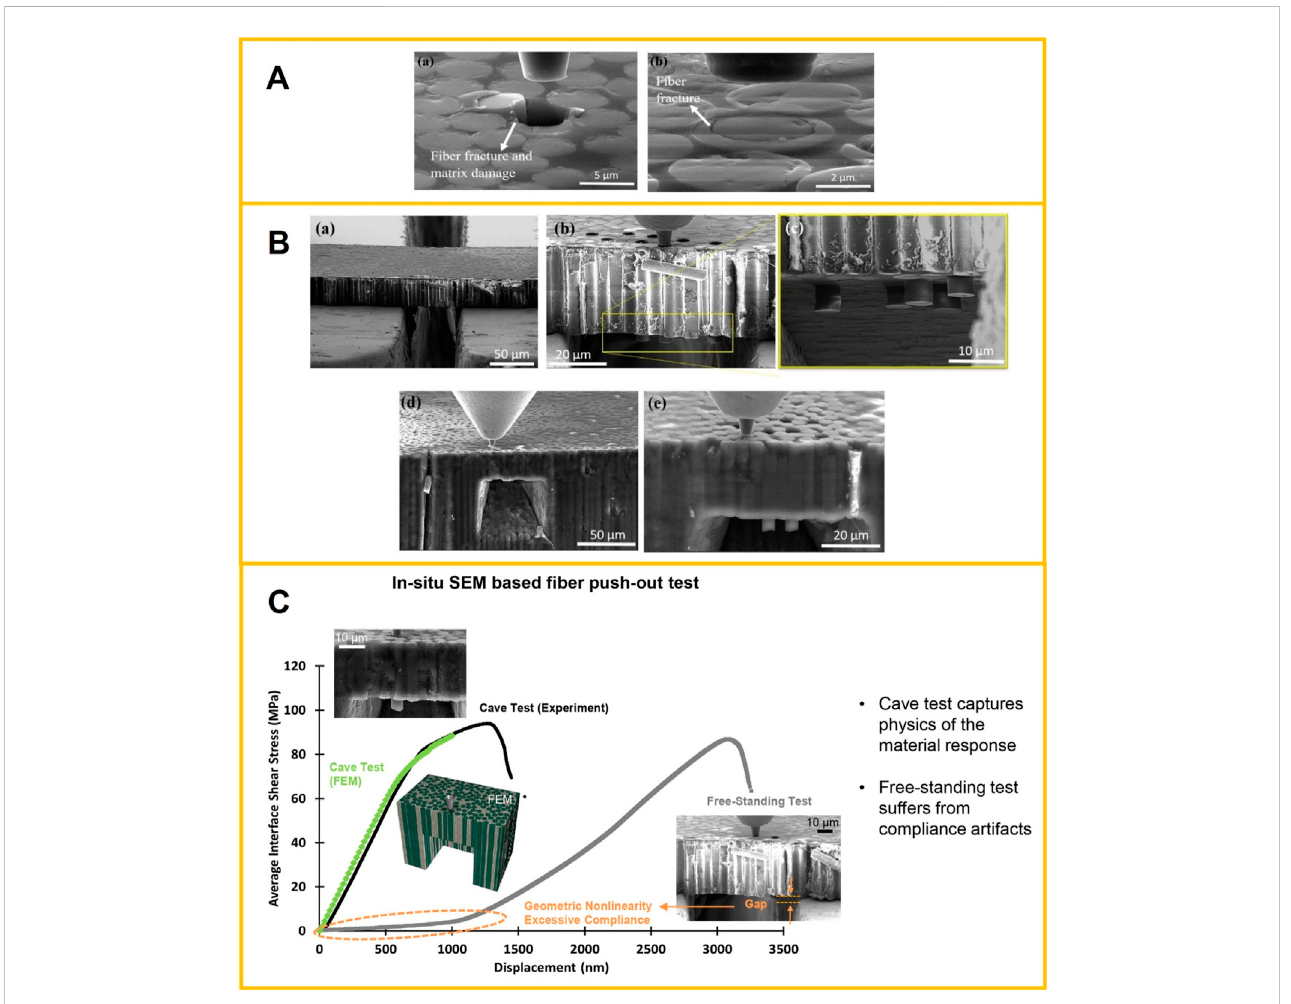
FIGURE 11 (A) Examples of SEM images from rejected push-out tests showing fi ber fracture and matrix damage due to load eccentricity. Reprinted with permission from (Ghaffari etal., 2021). Copyright2020 Elsevier Ltd. (B) Examplesof typical SEM imagesof (a) a free-standing sample before fi ber push-out testing and (b, c)aftertesting;(d)acavesamplebeforetestingand(e)aftertesting.Reprintedwithpermissionfrom(Ghaffarietal.,2021).Copyright2020ElsevierLtd. (C) The schematic diagram of in-situ SEM-based fi ber push-out test. Reprinted with permission from (Ghaffari et al., 2021). Copyright 2020 Elsevier